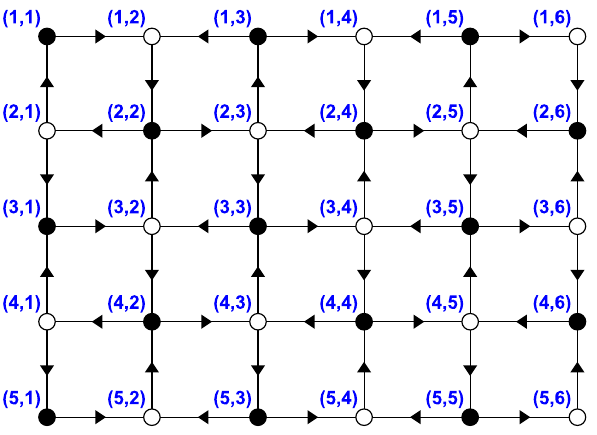
Figure 2: A grid P 5 × P 6 oriented according to Lemma